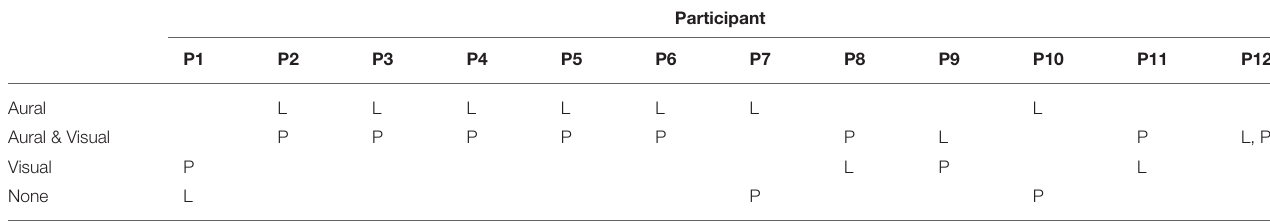
TABLE 3 | Participant stated preferences for favorite lesson type and what feedback method(s) they speculated they would most like during individual practice.